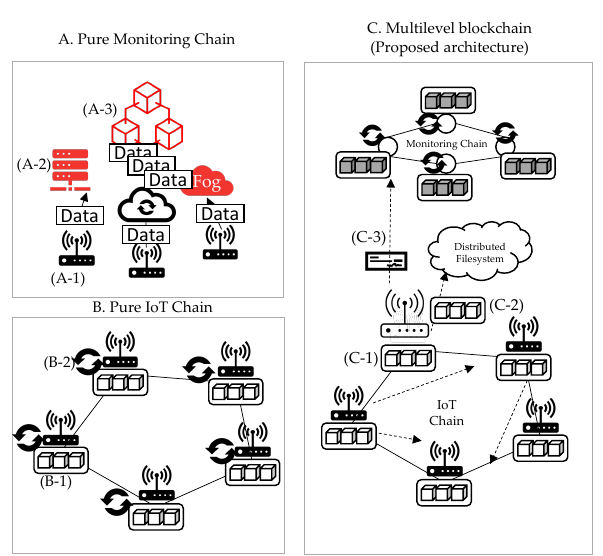
Figure 3. Multilevel blockchain structure.